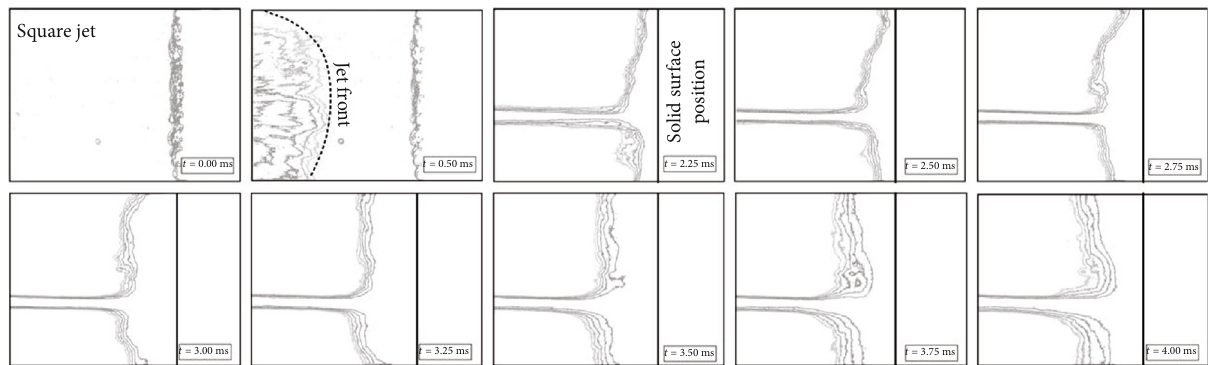
Figure 7: The evolutions of a square jet impacting a solid surface.